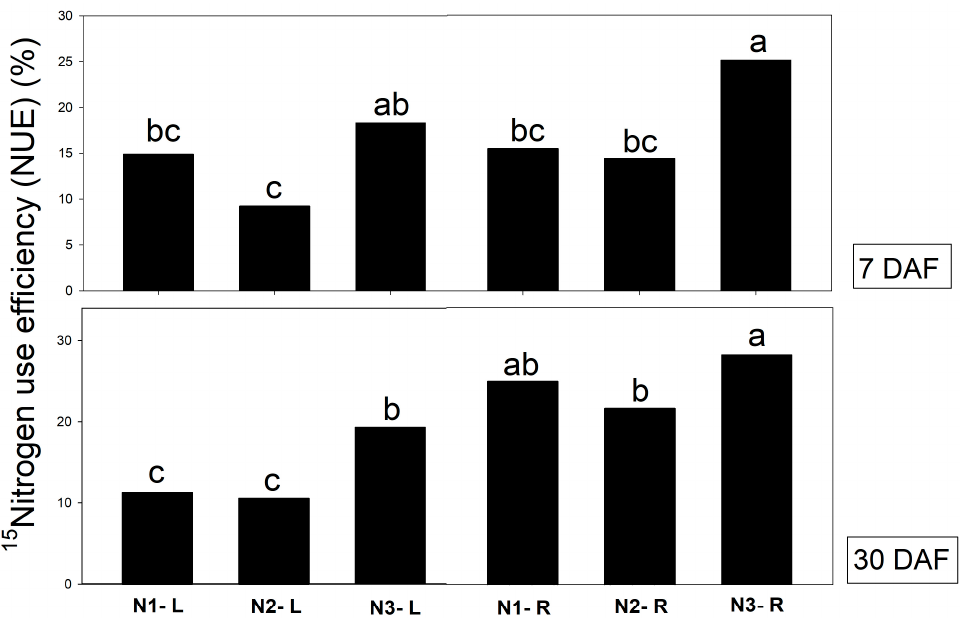
Figure 3. NUE in different organs of Vanda supplied with different labeled N sources (N1 = 2 . 5 mM 15 NO 3 − + 2 . 5 mM NH 4+ , N2 = 2 . 5 mM NO 3 − + 2 . 5 mM 15 NH 4+ , and N3 = 2 . 5 mM glutamine) via leaves (L) and roots (R) at 7 and 30 days after feeding (DAF). The different letters denote significant differences in treatments, analyzed by Tukey’s test. The 15 N increment percentage in Vanda was calculated . Plants supplied with 15 N so-